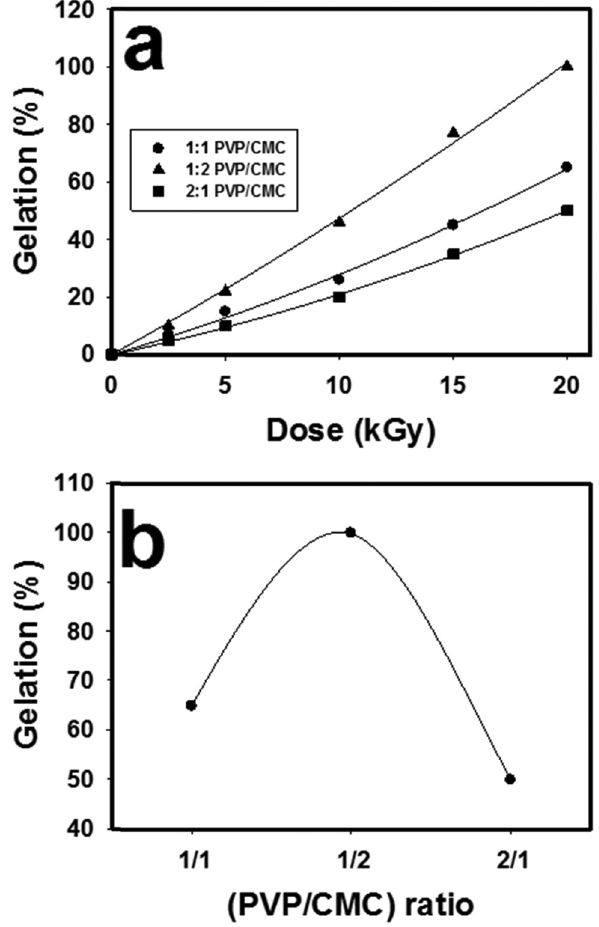
Figure 6: ( a ) E ff ect of irradiation dose on the gelation percentage and ( b ) e ff ect of PVP:CMC ratio on gelation percentage at 20